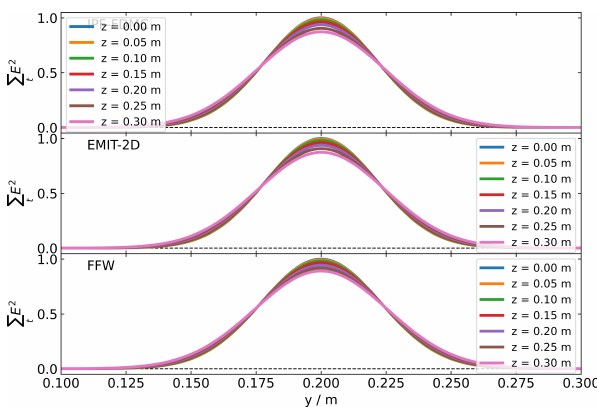
Figure 1. Full-wave simulation results obtained for scenario #1, shown is the time-averaged squared wave electric field at various cuts along the y -axis.